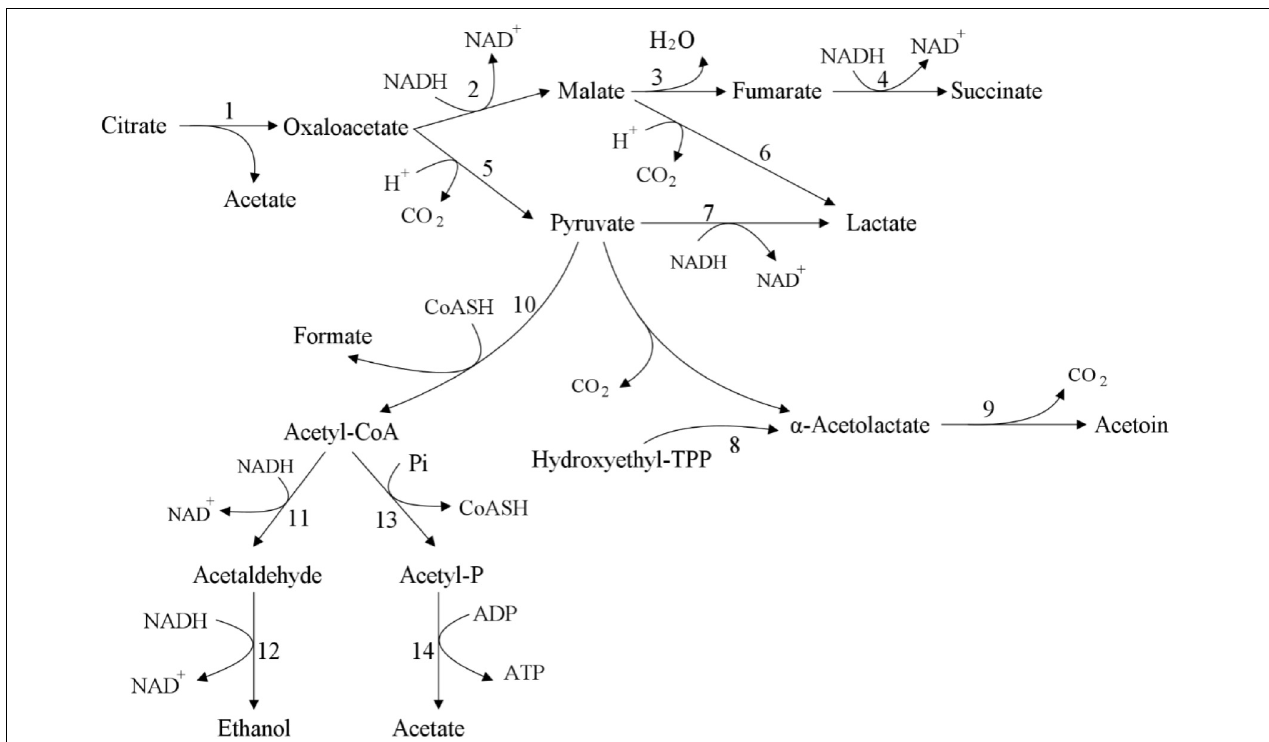
FIGURE 4 | Citric acid metabolism (Gänzle, 2015). The citric acid in lactic acid bacteria is converted into succinate, lactate, acetate, and ethanol or acetylacetone through the intermediate metabolite oxaloacetate. 1: citrate lyase; 2: malate dehydrogenase; 3: fumarate hydratase; 4: succinate dehydrogenase; 5: oxaloacetate decarboxylase; 6: malolactic enzyme; 7: lactate dehydrogenase; 8: acetolactate synthase; 9: acetolactate decarboxylase; 10: pyruvate formate lyase; 11: acetaldehyde dehydrogenase; 12: alcohol dehydrogenase; 13: phosphotransacetylase; 14: acetate